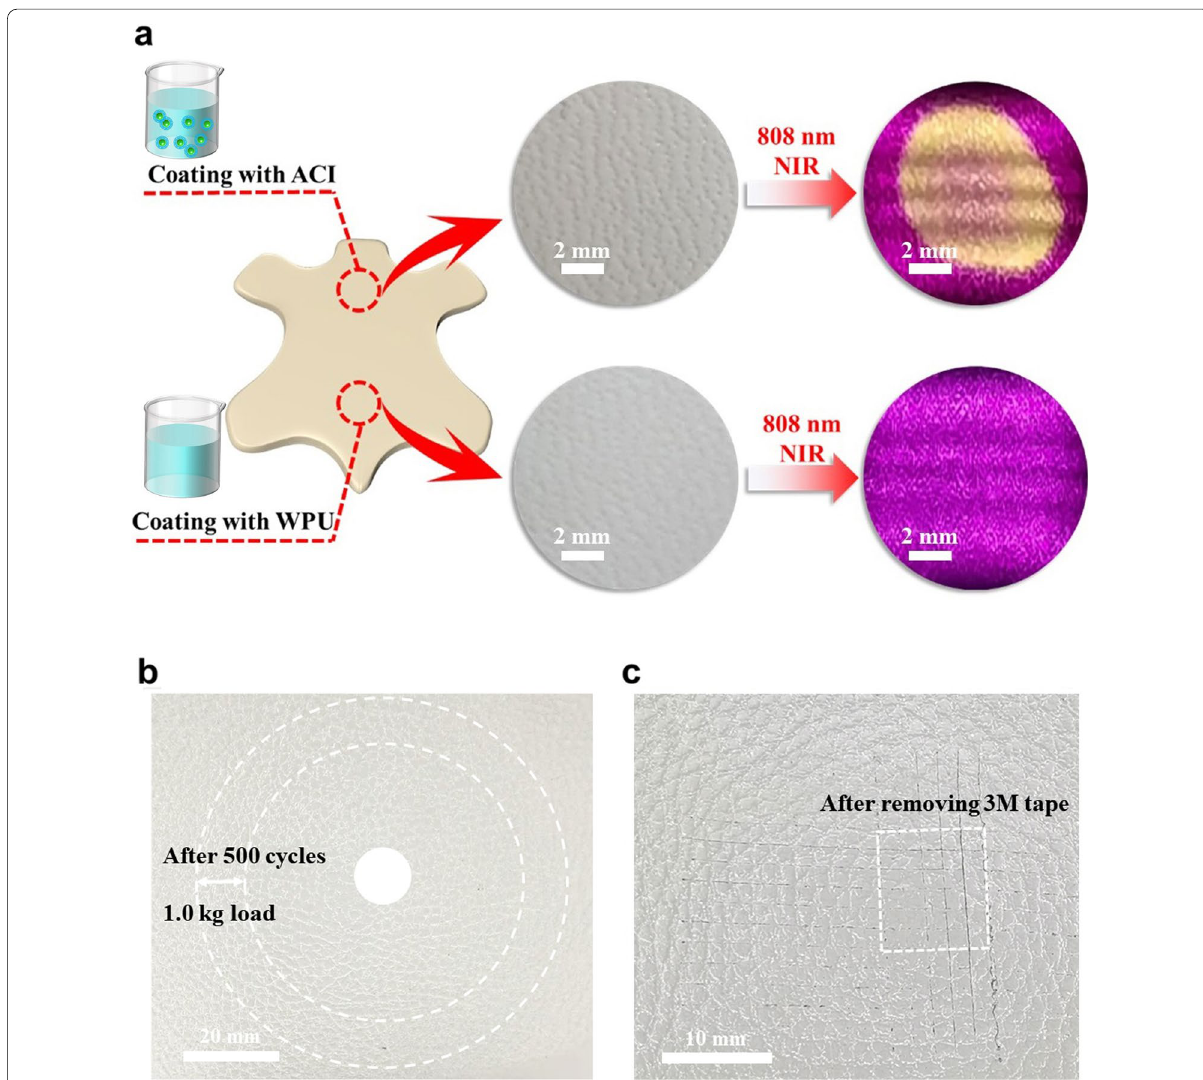
Fig. 5 a Naked eye observations of patterns formed by ACI and neat WPU on leather products: under normal light conditions (middle) and 808 nm NIR laser excitation (right). The digital images show ACLs after the abrasion test ( b ) and adhesive peel strength test ( c ) on the leather